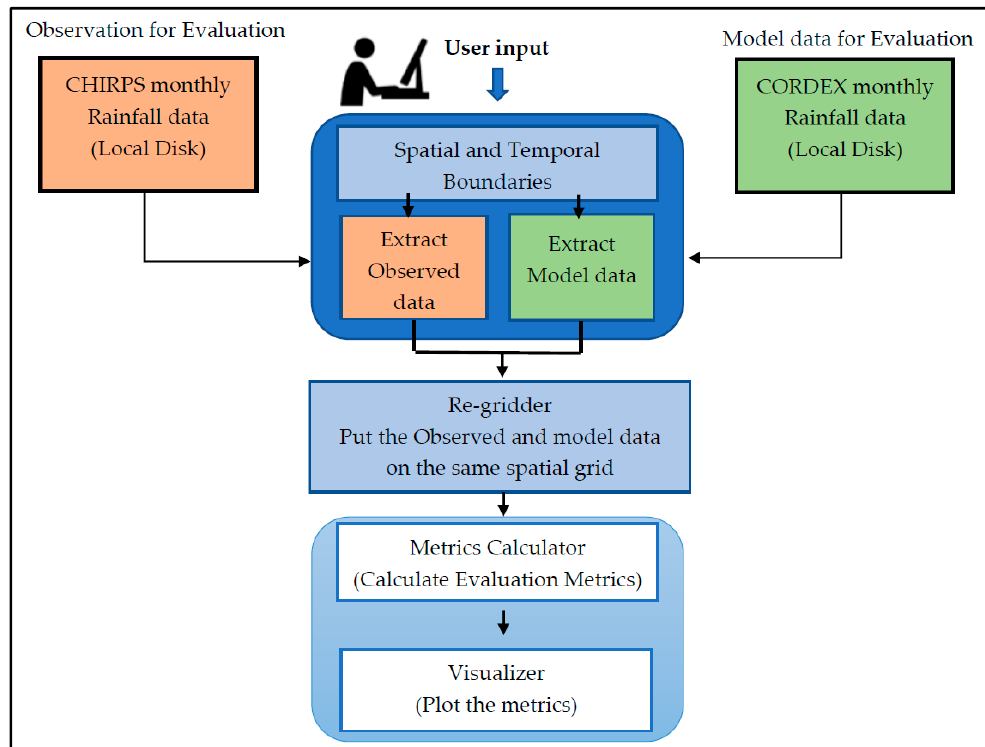
Figure A1. RCMES workflow for this study (Adapted from [36]).